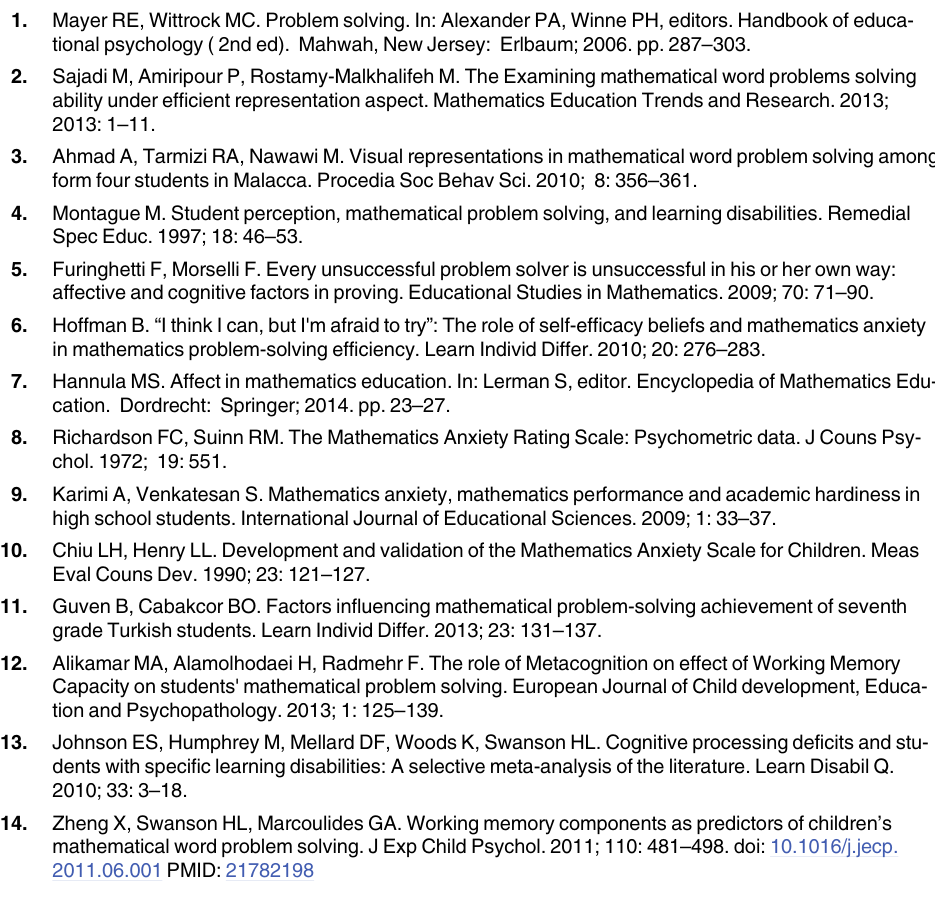
S1 Fig. Model 3: Partially mediated model with MA as a mediator and IQ partialled out. LMA = learning mathematics anxiety, MEA = mathematical evaluation anxiety. WPS = word problem solving. (cid:1)(cid:1)(cid:1) p < .001, (cid:1)(cid:1) p < .01. (TIF) S2 Fig. Model 4: Fully mediated model with MA as a mediator and IQ partialled out. LMA = learning mathematics anxiety, MEA = mathematical evaluation anxiety. WPS = word problem solving. (cid:1)(cid:1)(cid:1) p < .001, (cid:1)(cid:1) p < .01. (TIF) S1 Table. Fit indices for the structural equation modeling of mathematical metacognition, mathematics anxiety, and word problem solving with MA as a